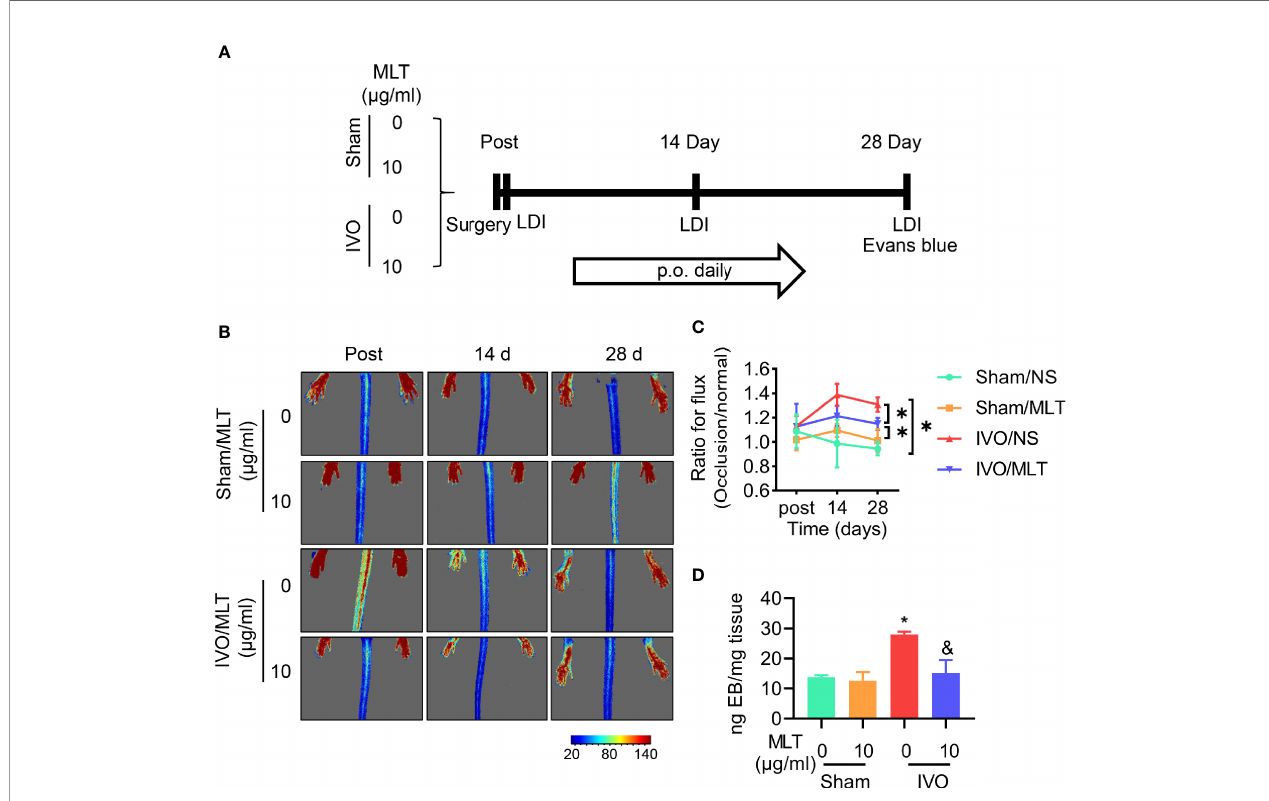
FIGURE 1 | MLT inhibits permeability in a mouse model of iliac vein occlusion (IVO). (A) Schematic representation of experimental procedure. p.o., per os. (B, C) The blood fl ow perfusion of ligated or normal hindlimb was detected after surgery (post), 14 days (14 d), and 28 days (28 d) after surgery using the laser speckle system. Sham/normal saline (NS; n = 5), sham/MLT ( n = 5), IVO/NS ( n = 5), and IVO/MLT ( n = 10). (B) Representative perfusion images were shown. (C) Quantitative analysis of blood perfusion with the ratio of left (occlusion) to right (normal). * p < 0.05 (D) Quantitative content of Evans blue in semimembranosus (SM) muscle of mice. Sham/NS ( n = 4), sham/MLT ( n = 4), IVO/NS ( n = 4), and IVO/MLT ( n = 5). * p < 0.05 vs. sham/NS, & p < 0.05 vs. IVO/NS. Data presented as mean ±